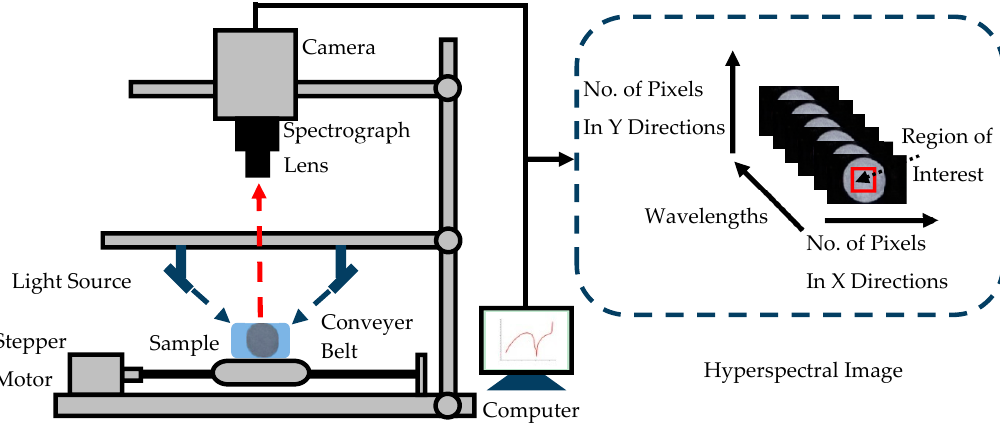
Figure 1. Schematic diagram of the hyperspectral imaging system. This system can obtain images in the spectral region of 874–1734 nm.